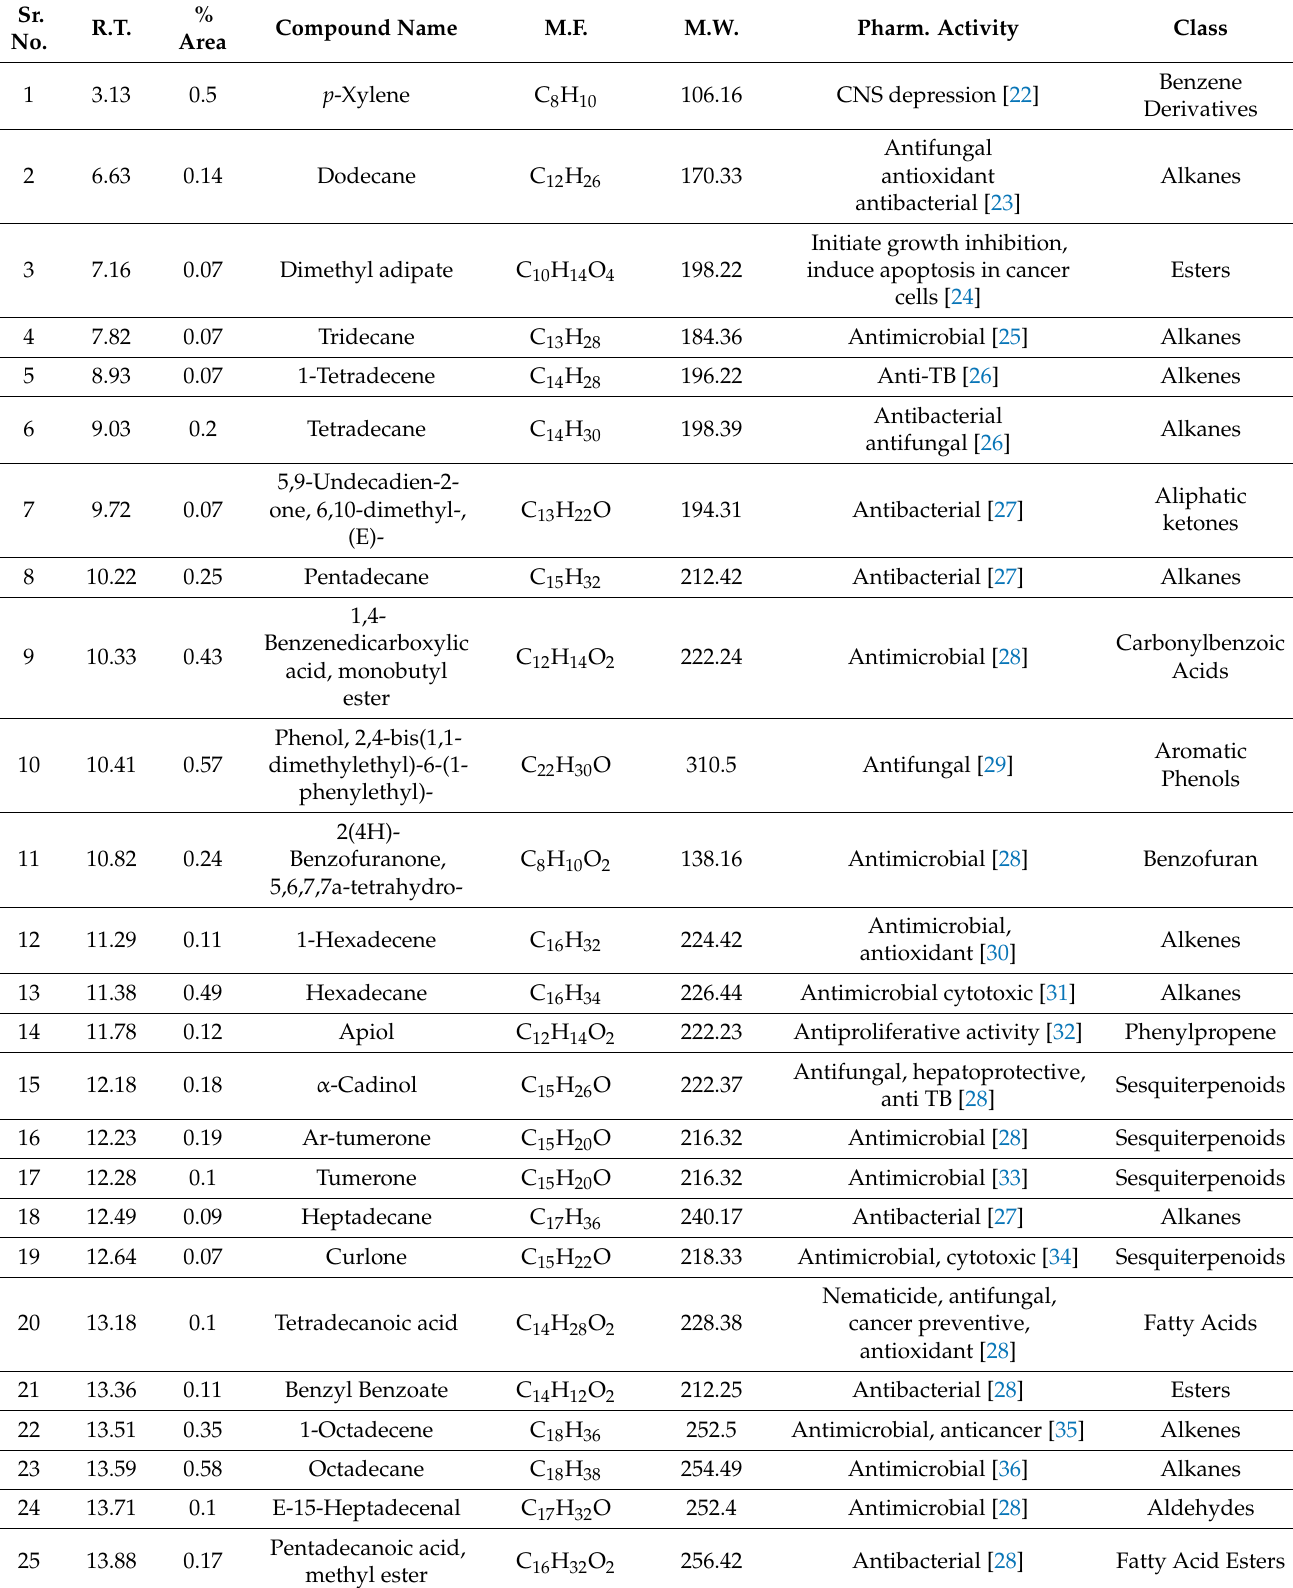
Table 3. Metabolic profile of the n -hexane fraction in Dracaena reflexa by GC-MS analysis.